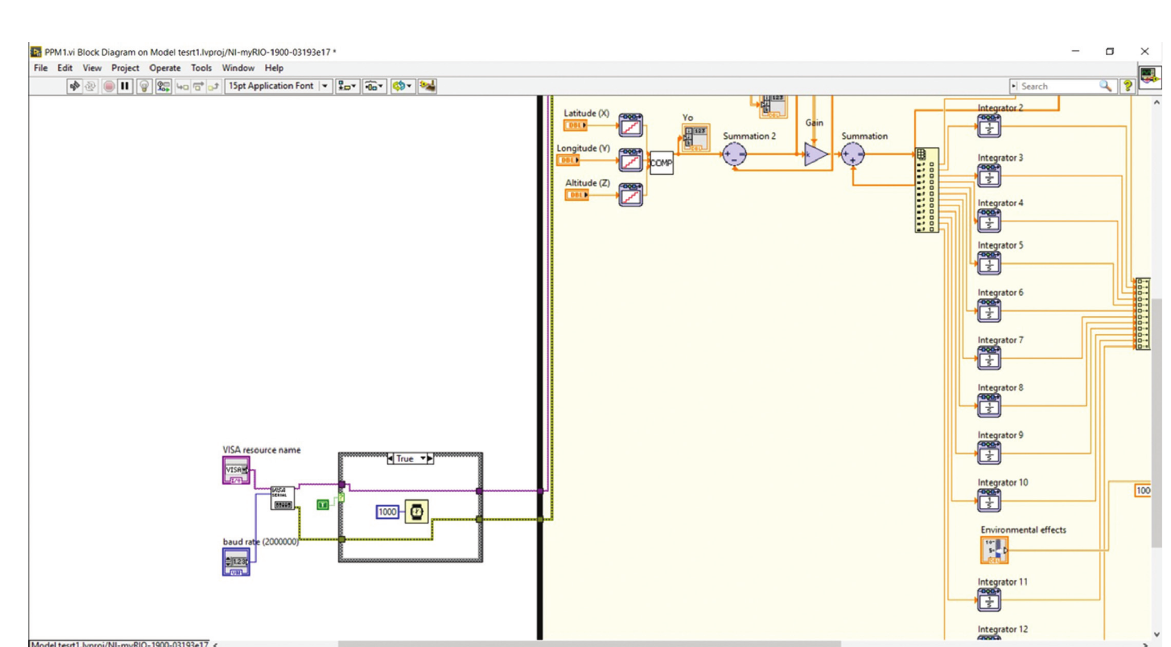
Figure 8: myRIO Serial Receiving Setup for ATmega Microcontroller.